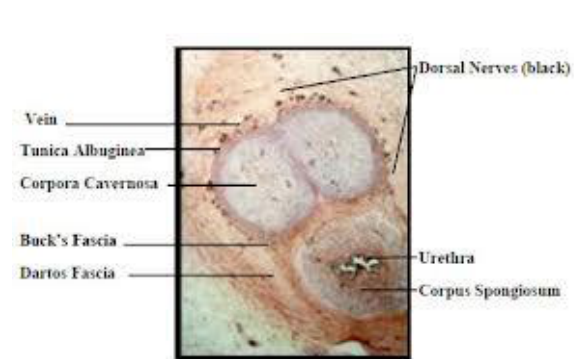
Figure 1: demonstrating corporal bodies of penis with nerves distribution. (4)